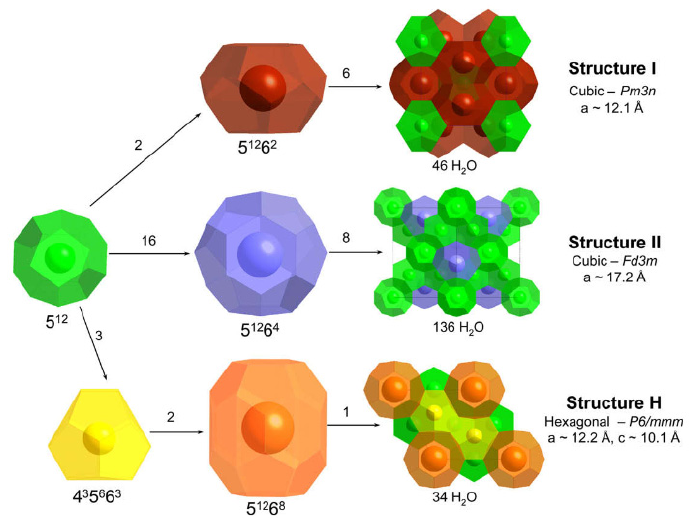
Figure 2. Discovered clathrate hydrate structures: cages, water units and unit cage [25] (Reprinted from [25], Copyright (2009), with permission from Elsevier).